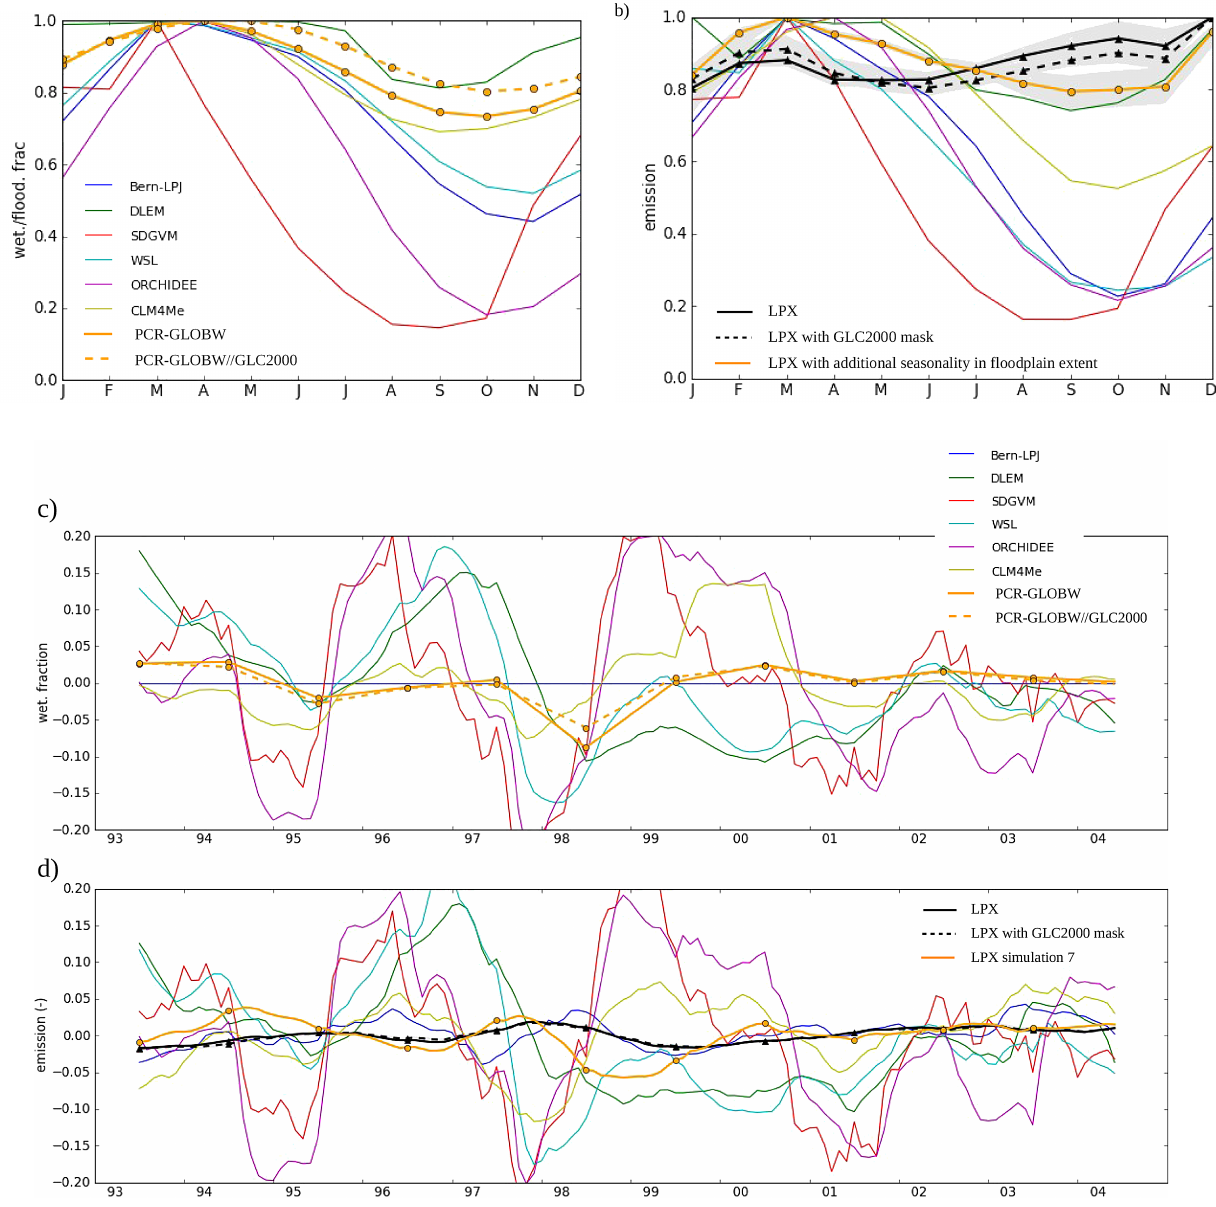
Fig. 11. Comparison of the temporal variability (seasonal and IAV) in wetland extent and associated CH 4 emissions between WETCHIMP models and LPX. For LPX-floodplain CH 4 emissions (panels b and d ), the grey area corresponds to a range (max–min) of the simulations 1–6 (cf. Table 5) while the black line corresponds to the mean of the same simulations. In the same panels, the orange curve corresponds to emissions when the corresponding (either seasonal or interannual) variability in flood extent is accounted for to compute emissions (see below for specificities about the seasonal cycle). The dashed line corresponds to the application of the GLC2000 filter to the PCR-GLOBWB floodplain